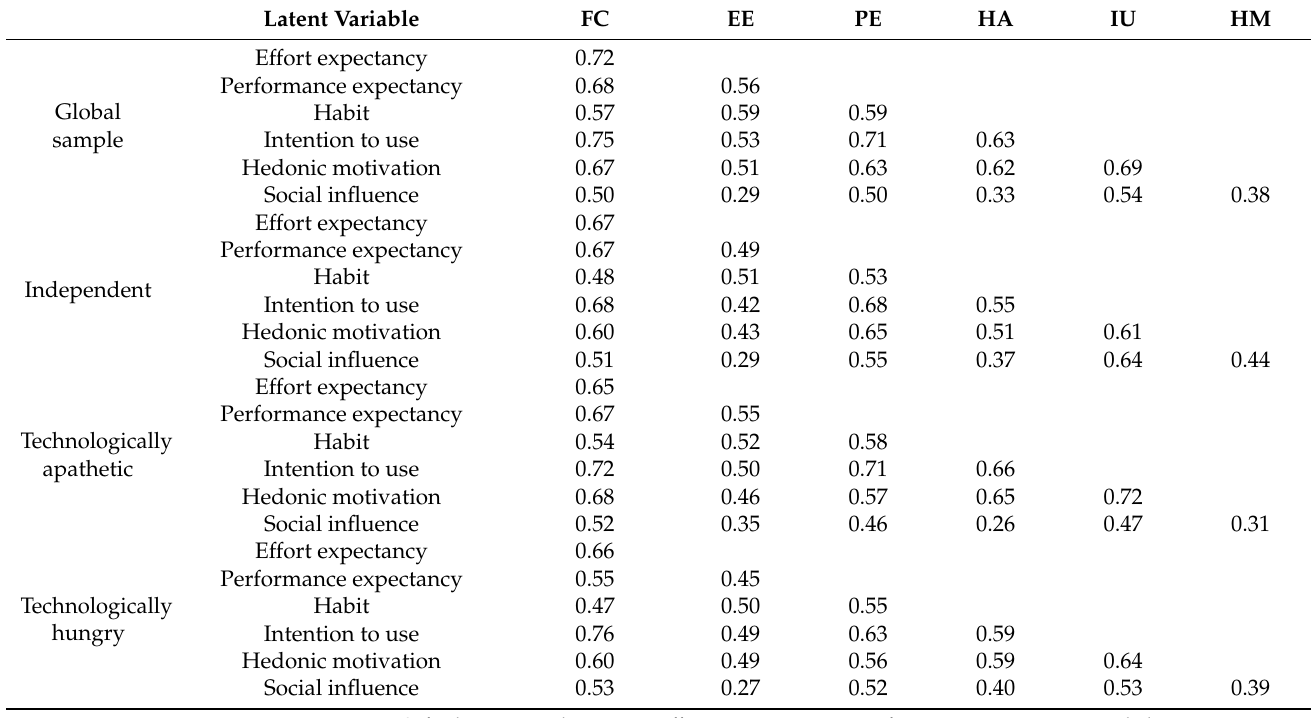
Table 4. Discriminant validity assessment.